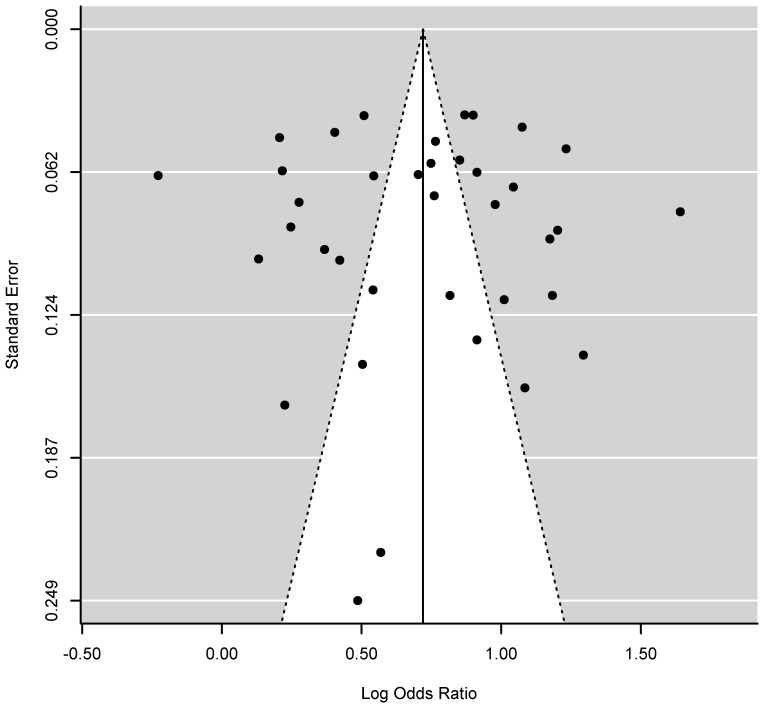
Funnel plot of the log odds ratios (ORs) of probable PTSD risks associated with WTC-related exposure for the meta-analysis of the ten studies included in the meta-analysis.Note: The points correspond to the 37 individual ORs. The funnel shape indicates the expected 95% confidence intervals around the summary estimate (vertical line). Little evidence of publication bias was found based on the symmetry of the funnel plot, which was also confirmed by both the Begg's test (p-value = 0.89) and Egger's test (p-value  =  0.93).